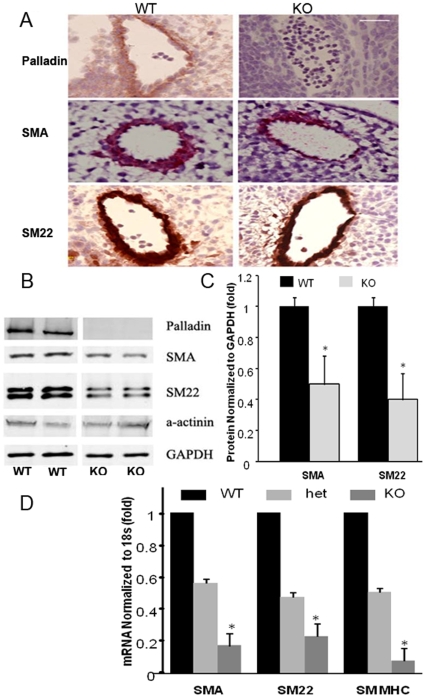
SMA and SM22 expression was attenuated in homogenates of palladin E11.5 knockdown embryos, in isolated umbilical vessels and in dorsal aortae.A) Representative images show that the expression of SMA and SM22 was attenuated in dorsal aortae at E11.5 embryos by immunohistochemistry analysis. Embryos were fixed and embedded for sectioning. Frontal sections were stained with palladin, SMA, and SM22 antibodies and corresponding secondary antibodies conjugated with biotin. The signals were developed with DAB and photographed on a Axioskop 2 Zeiss microscope. Scale bar, 50 µm. B) Western blots showing a significant decrease in the protein expression of SMA and SM22 in homogenates of whole embryos with its quantification shown in C. The whole embryos were dissected genotyped, and homogenized in RIPA buffer. An equal amount of protein was loaded for SDS-PAGE, and blotted with SMA, SM22, palladin, SMC specific α-actinin, and GAPDH antibodies. The signals were normalized to GAPDH. Values represent the mean±SEM (n = 3). *, p<0.05. D) The expression of SMA, SM22, and SM MHC mRNA is markedly decreased in umbilical vessels isolated from E11.5 palladin +/− and −/− mice compared to Wt. Umbilical vessels were dissected from E11.5 wt, het, and knockdown E11.5 embryos. RNA was extracted and SMA, SM22 and SM MHC quantitated by real time RT-PCR. Data was normalized to 18s. Values represent the mean±SEM (n = 3). *, p<0.05.